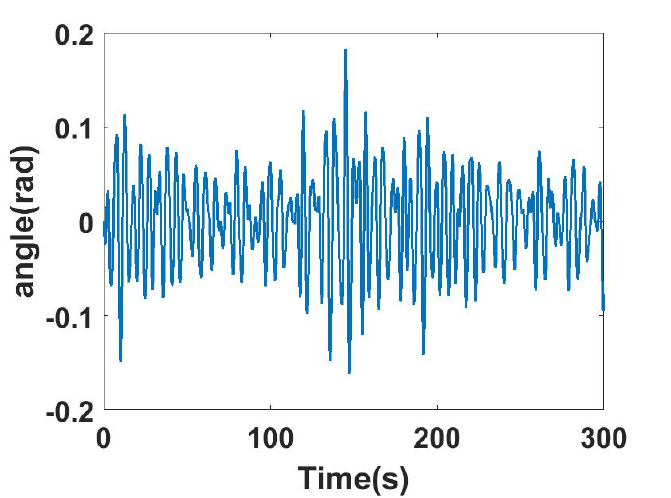
Figure 15. The rotational